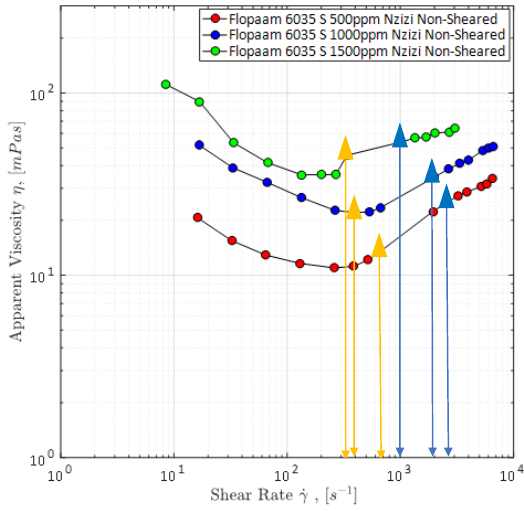
Figure 19. Apparent viscosity of HPAM solutions with different polymer concentrations measured during micromodel single-phase flooding. Yellow triangles mark the onset of transitional flow regime and blue triangles mark the onset of fully developed elastic turbulence [69].